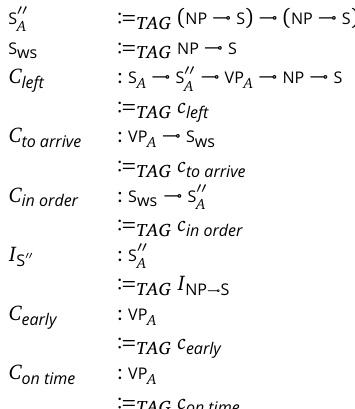
Constants of (cid:6) TAG and their interpretation by G